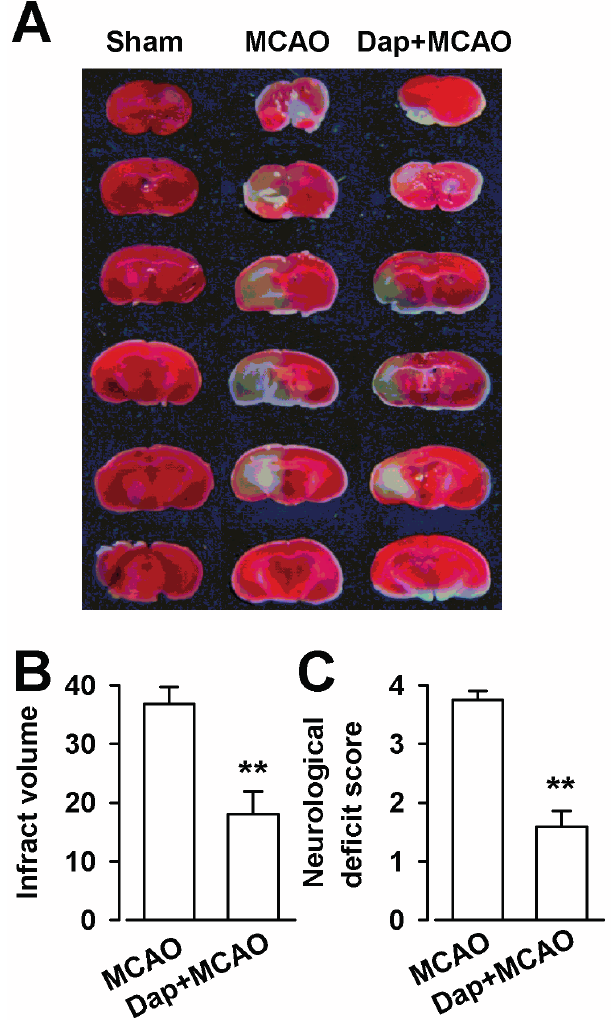
Figure 6. Effects of Dap on infarction volume and neurological deficit score after MCAO in mice. ( A ) Representative photograph of TTC staining of coronal brain sections (1 mm thick) from mice subjected to MCAO. Non-ischemic region is in red and the infarct region appears in white. ( B ) Infarct volume was measured at 24 h after MCAO. ( C ) The neurological deficit scores of mice were measured at 24 h after MCAO. n = 6, ** p < 0.01 compared with MCAO